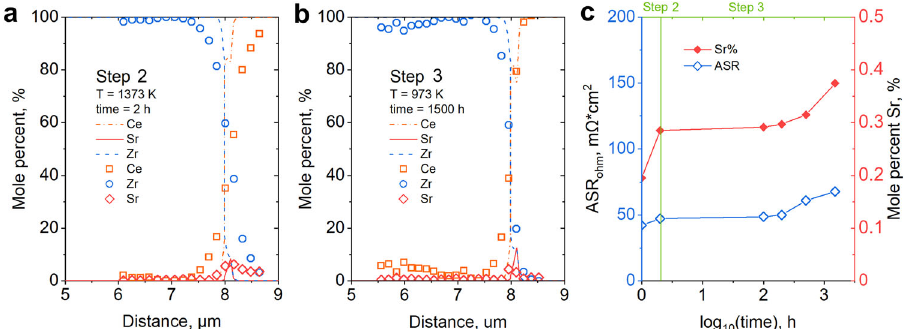
Fig. 4 Composition pro fi les across the oxygen electrode – electrolyte interface (PLD CGO). a , b Simulation (dashed lines) of the SZO formation at the YSZ – CGO interface during cathode sintering (Step 2) and long-term operation (Step 3) in comparison with the experimental data (scattered symbols) 16 . c Estimated amount of Sr in the simulated IDZ and the corresponding ASR ohm at 700 °C. Distance at 0 μ m corresponds to the left boundary of the ZrO 2 layer, and the original ZrO 2 – CeO 2 interface is located at 8 μ